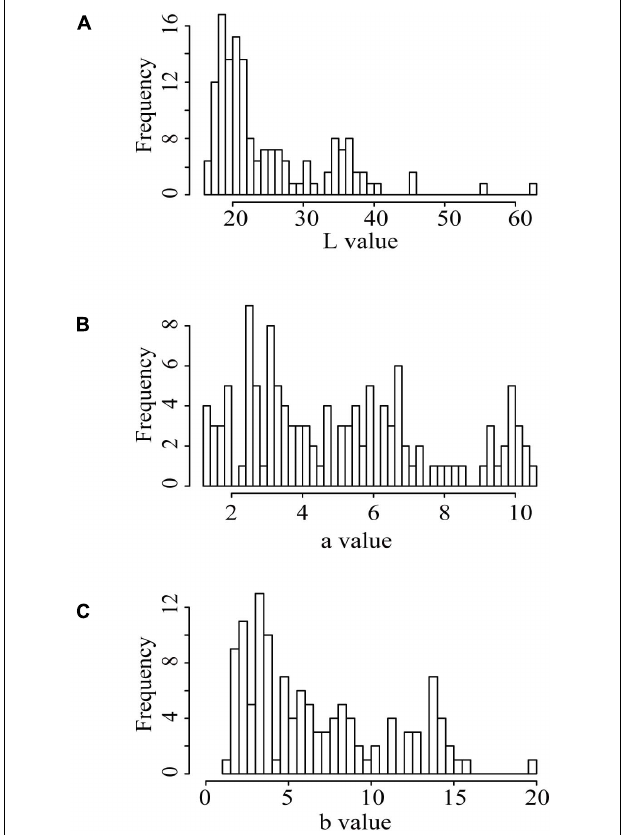
FIGURE 1 | Distribution of the seed coat color indices presented by the L , a , and b values in the F 2 population. (A) “ L ” value; (B) “ a ” value; (C) “ b ” value.